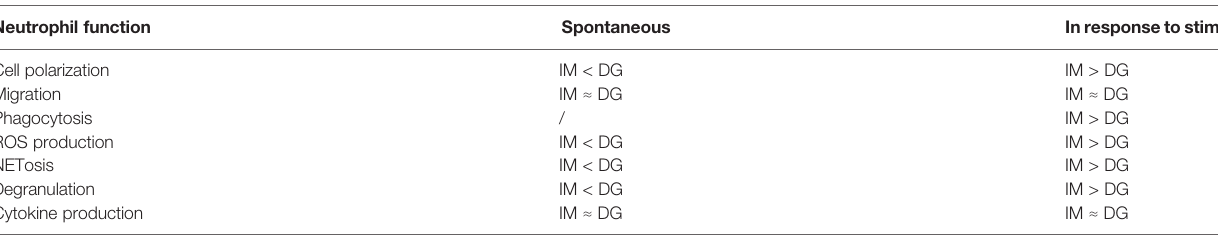
TABLE 1 | Summary of the